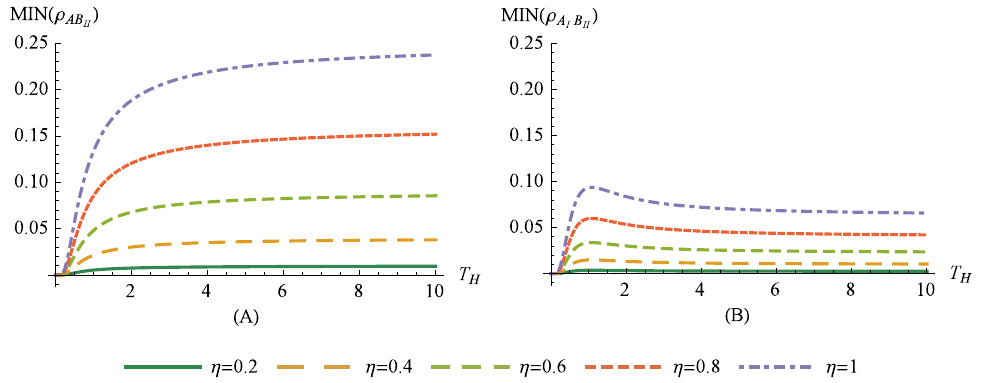
Figure 4. The measurement-induced nonlocality (MIN) as a function of the Hawking temperature ( T H ) for the physically inaccessible correlations in the case of ( A ) the fermionic and ( B ) the mixed modes. The results are presented for the selected values of the entanglement parameter ( η ) and for the fixed fermionic ( ω = 1) and bosonic frequencies ( Ω =